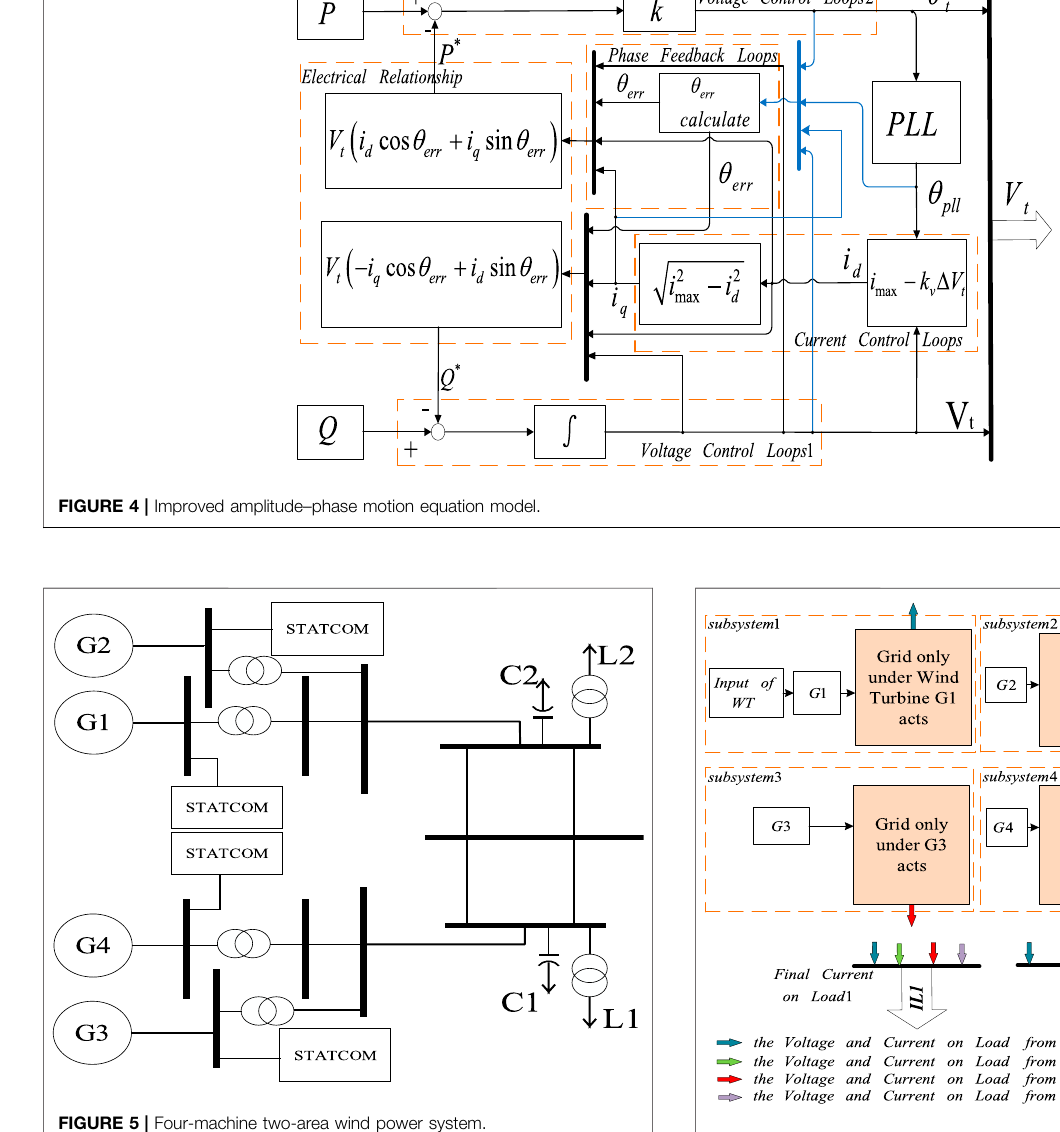
FIGURE6 | Block diagram of thefour-machinetwo-area power